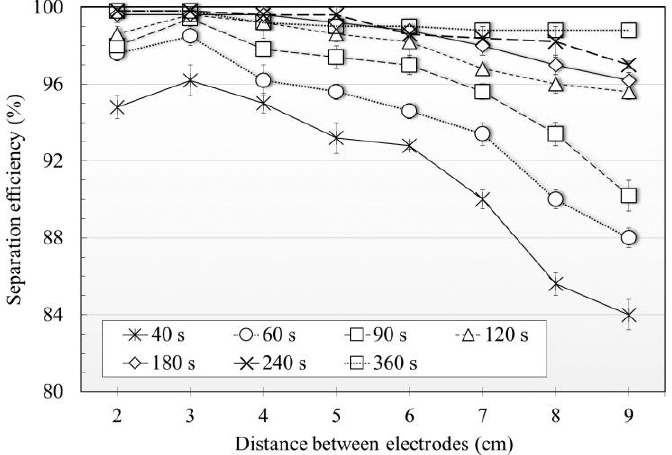
Figure 11. Effect of vertical distance between electrodes (d) with different separation time on the separation efficiency of the EDS process using iron (Fe) electrodes with point-to-point electrode configuration and applied AC voltage of 3 kV.